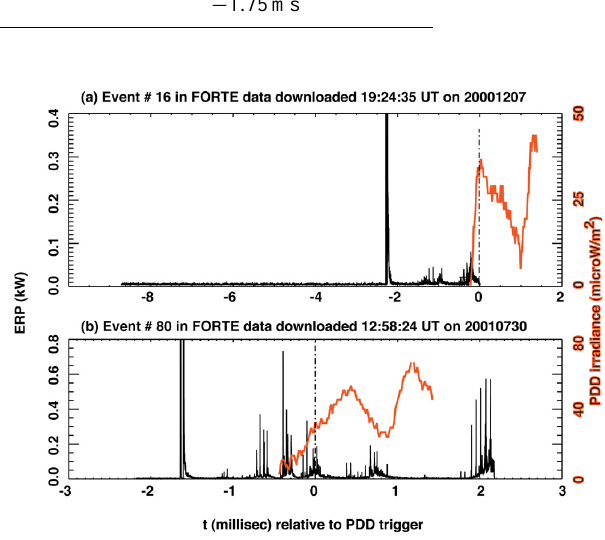
Fig. 5. ERP versus time (black) and optical irradiance versus time (orange) for (a) the second and (b) the third of the six HUMR–PDD events of Table 4. The dashed vertical lines mark the PDD trigger time, defined as